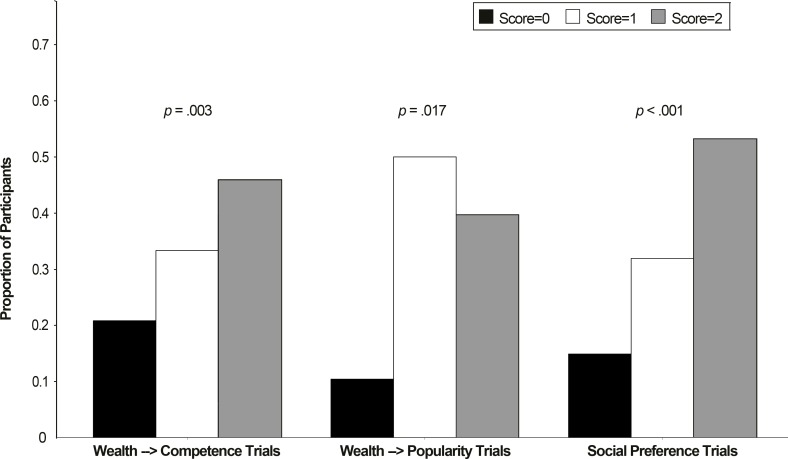
Responses of Participants in Study 2.The graph displays the proportion of participants in Study 2 who received scores of “0,” “1,” and “2” on different trial types. P-values note violations from the expected normal distribution; the normal distribution would be one quarter of participants with scores of “0,” half of participants with scores of “1,” and one quarter of participants with scores of “2.”